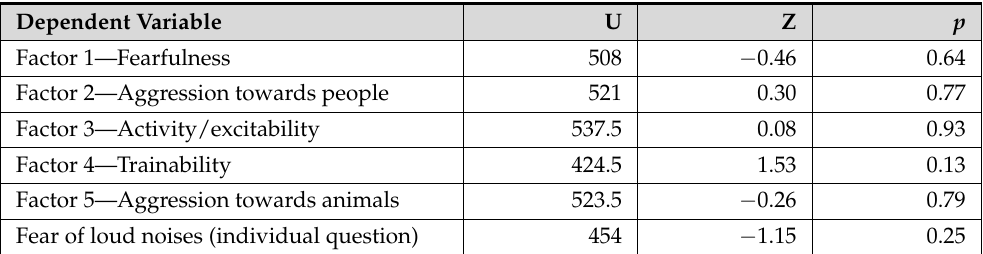
Figure 3. Association between puppies’ age at testing and “PC 2—Whimpering”. Table 11. Results of the linear mixed-effects model assessing the effect of treatment, age, litter size, and sex on “ PC 4 — Exploration ” . The p -value for litter refers to the ANOVA comparing the models with and without litter included. “ Bonferroni- corrected α for treatment” indicates the alpha level (after sequential Bonferroni correction) to determine whether the treatment effect was significant. Table 12. Results of Mann–Whitney U tests comparing the DPQ personality factors and fear of loud noises between the treatment and the control group.